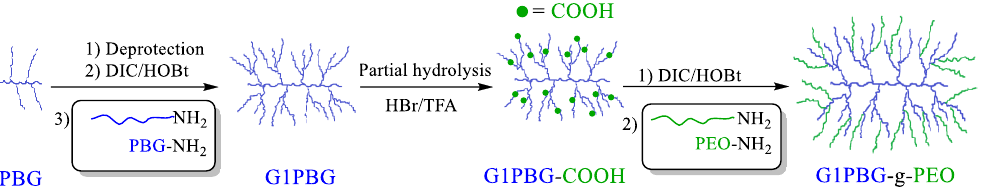
Table 2. Characteristics of randomly grafted PBG- g -PEO arborescent